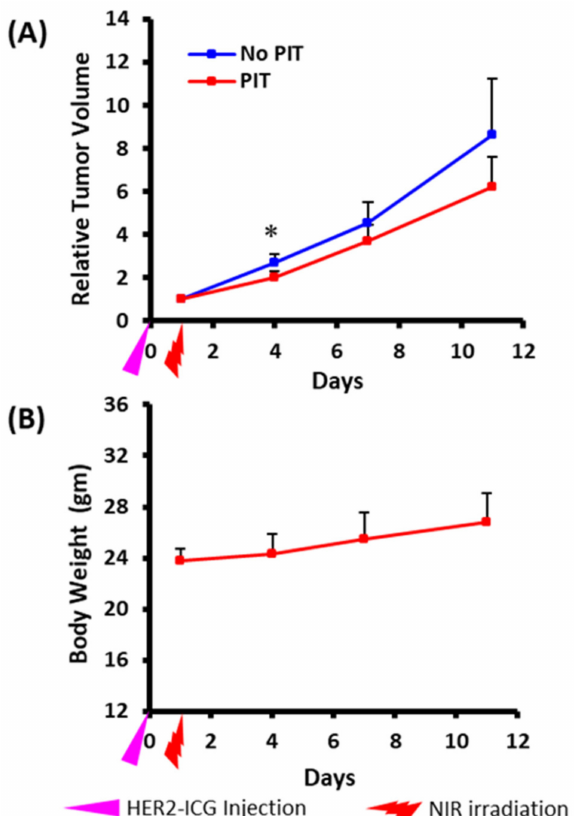
Figure 3. Photoimmunotherapeutic effects on tumor and body weight changes in mice. ( A ) Tumor volume change is shown as the ratio of the volume on the indicated day and the volume one day before the start of photoimmunotherapy (PIT). Tumors treated by NIR (PIT) (red) showed slow growth rates compared to contralateral tumors that received no treatment (no PIT) (blue). The difference was significant at day three after PIT. Values shown represent means ± SD ( n = 5), * p < 0.05 for PIT vs. no PIT. ( B ) There was no average body weight loss. The pink arrowhead indicates the day of administration of HER2-ICG and the red arrowhead indicates the day of NIR